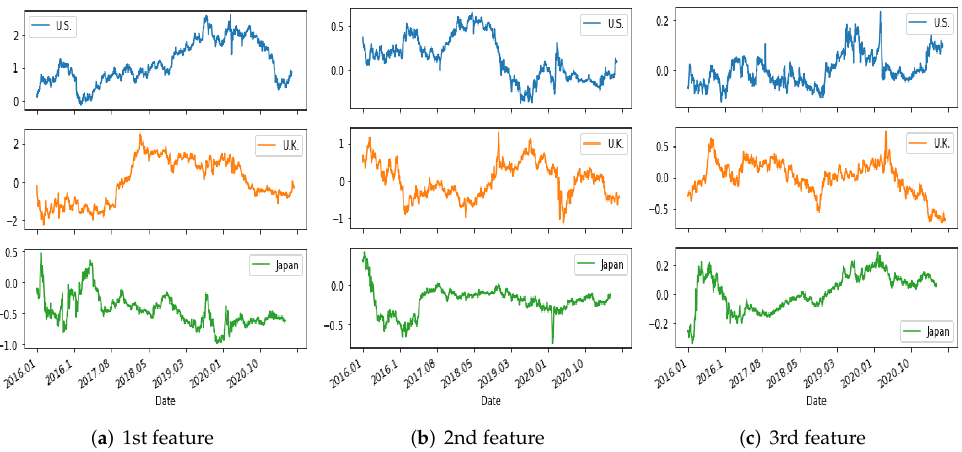
Figure 10. Time series of the first three features for the three